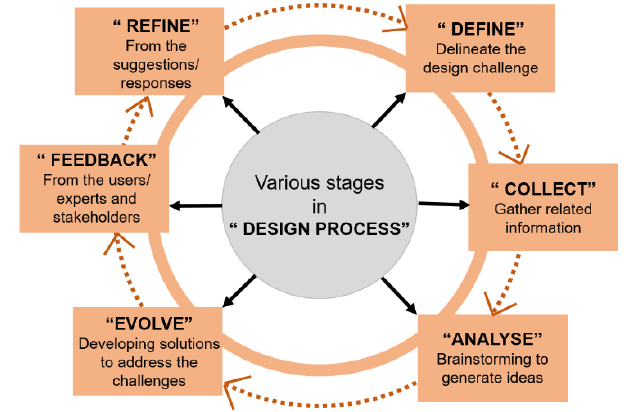
Figure 1. Mapping of design process (source: created by